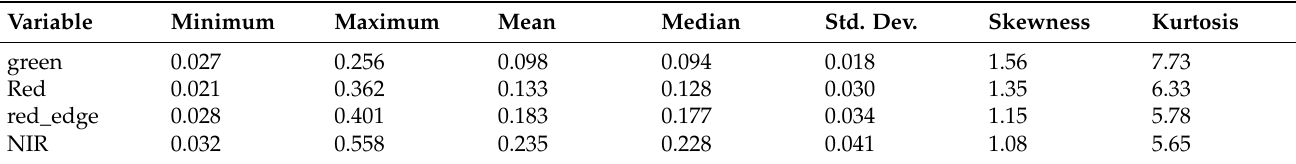
Table 2. Basic statistics of the four bands of drone reflectance.